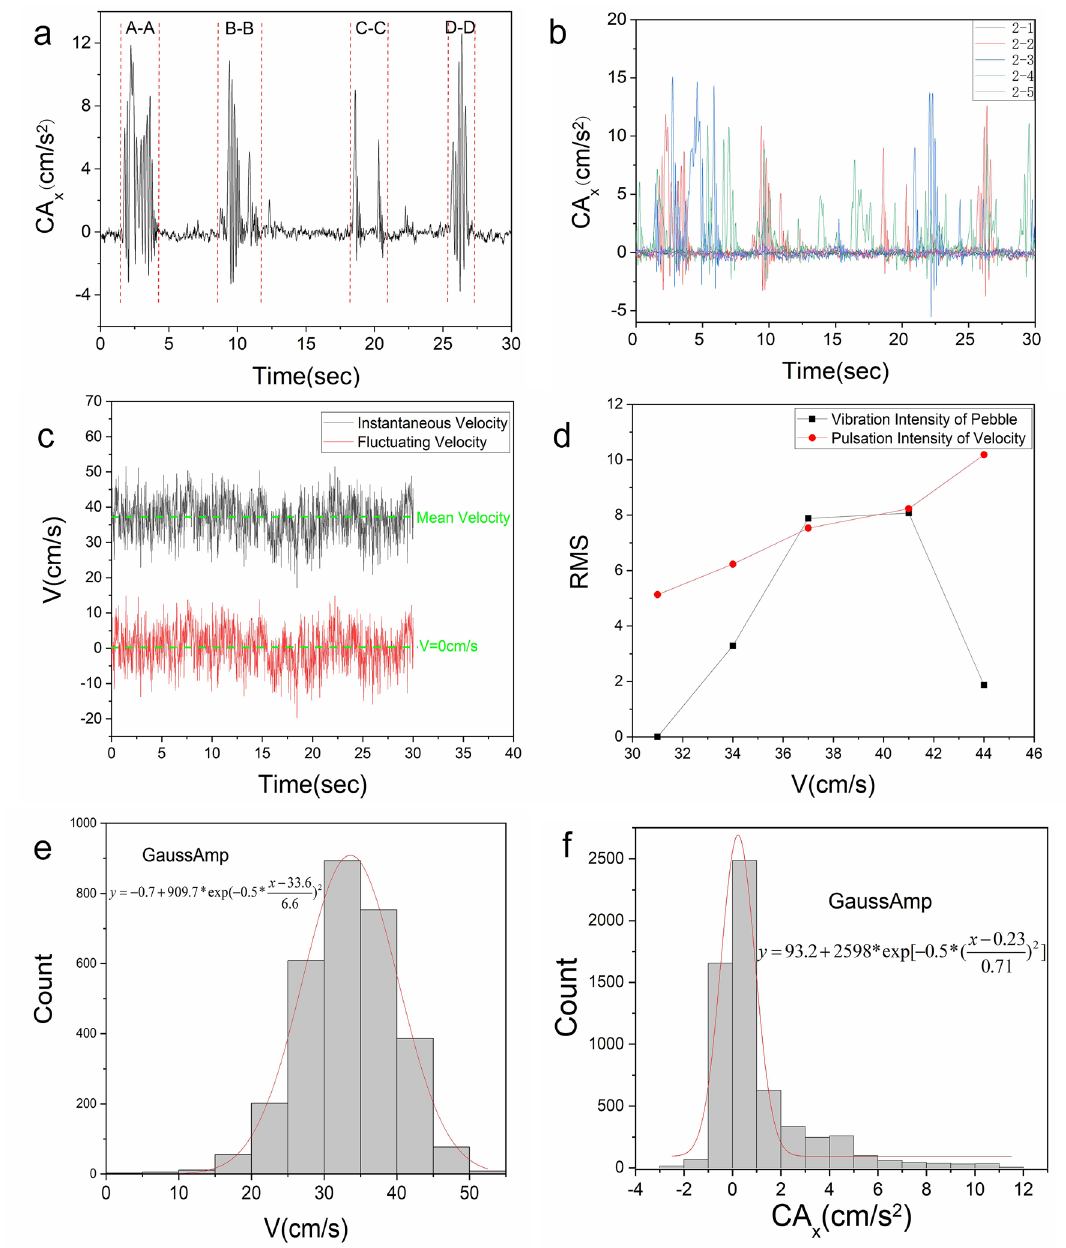
Figure 3. Time domain characteristic curve of pebble vibration and near-bed velocity. ( a ) Classification of pebble vibration types (Representative time series of CA x ,The dashed range indicates the type of ectopic strong vibration). ( b ) Time course of vibration acceleration for the same flow rate and different position conditions. ( c ) The signal of fluctuating velocity and instantaneous velocity. ( d ) Vibration intensity and flow pulsation intensity versus near-bottom flow velocity. ( e ) Probability distributions of near-bed velocity. ( f ) Probability distributions of vibration acceleration (CA x